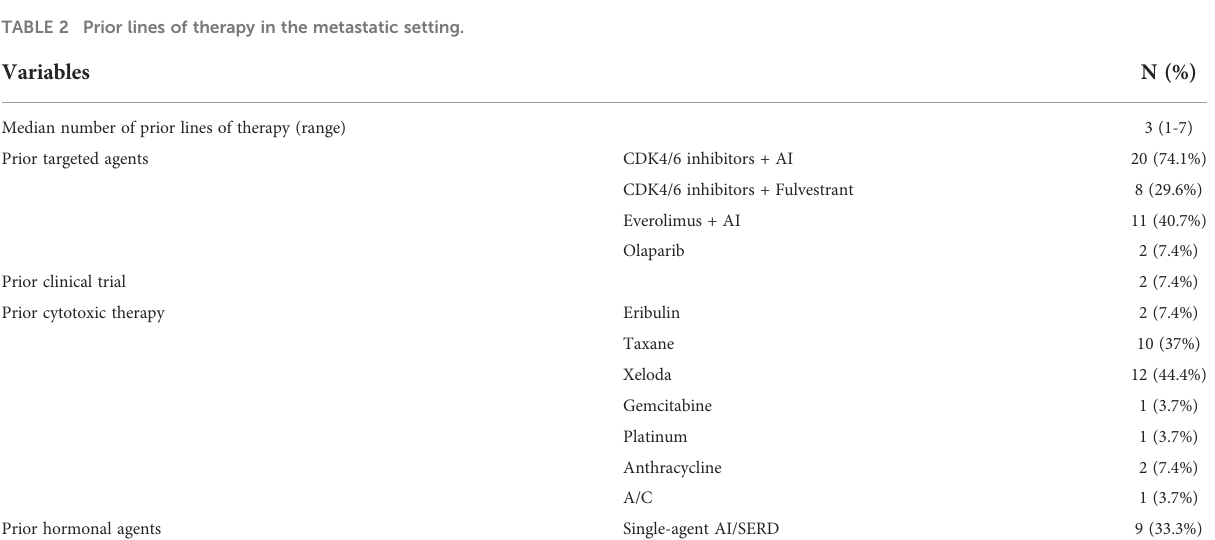
(Table 1). Of note, 3 patients had double PIK3CA mutations.